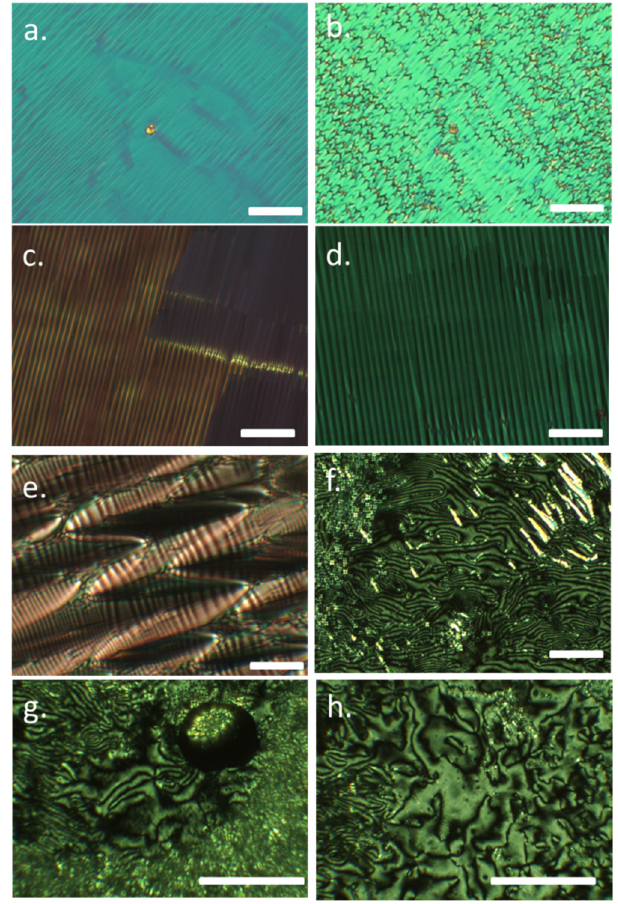
Figure 1. Photomicrographs of compound CB8OFFFT : ( a ) the rope texture of the twist-bend phase forming at 94.5 °C; ( b ) parabolic defects in the SmC A phase at 92 °C; ( c ) slow cooling (0.1 °C min − 1 ) across the nematic (N TB )-SmC A transition shows the transition front, the rope texture of the N TB (left) is retained in the SmC A phase (right) with a significant change in birefringence (93.3 °C); ( d ) rope-texture of the SmC A phase at 85 °C; ( e ) striations visible in the focal-conic texture of the SmC A phase at 91.5 °C sandwiched between untreated glass; ( f ) schlieren texture of the SmC A phase at 90 °C; ( g ) six-brush dispirations in the schlieren texture of the SmC A phase at 91 °C (200× magnification); ( h ) two-brush defects in the schlieren texture of the SmC A phase at 93.1 °C. The scalebar is 100 µ m in all cases.